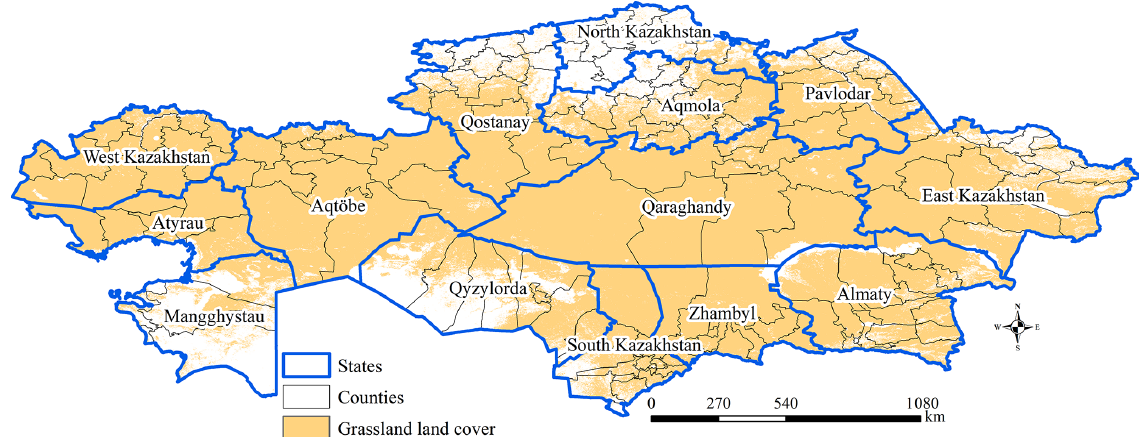
Figure 1. The distribution of grassland cover in Kazakhstan with counties and states shown as administrative boundaries.